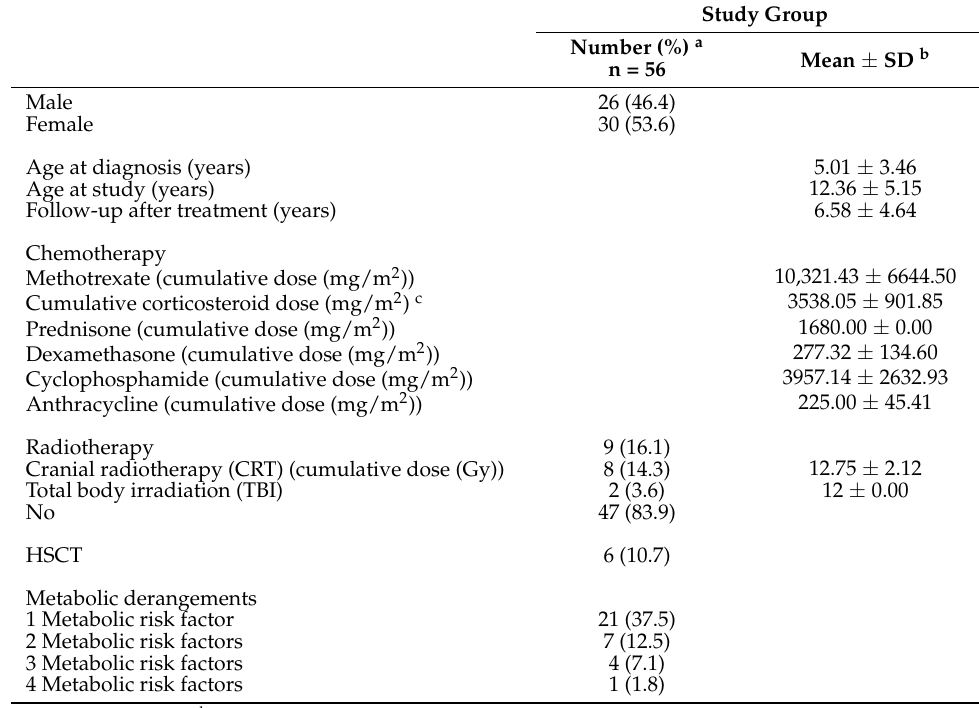
Table 2. Descriptive characteristics of acute lymphoblastic leukemia survivors.